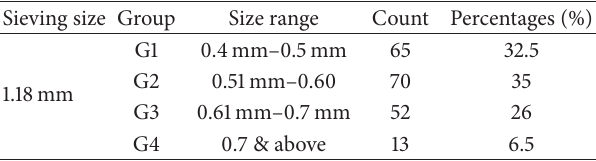
Table 3: Percentage of particles and the